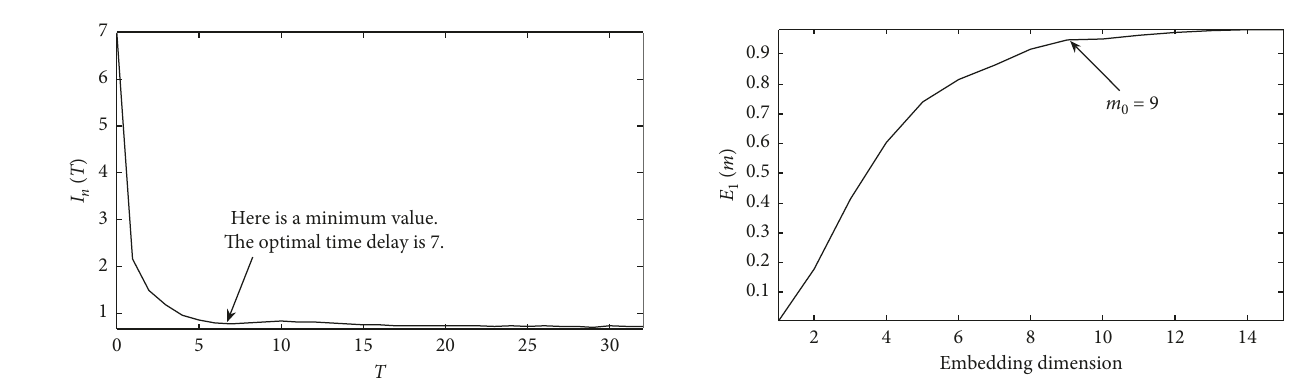
Figure 7: Self-mutual information method for optimal time delay. Figure 8: Cao’s method for minimum embedding